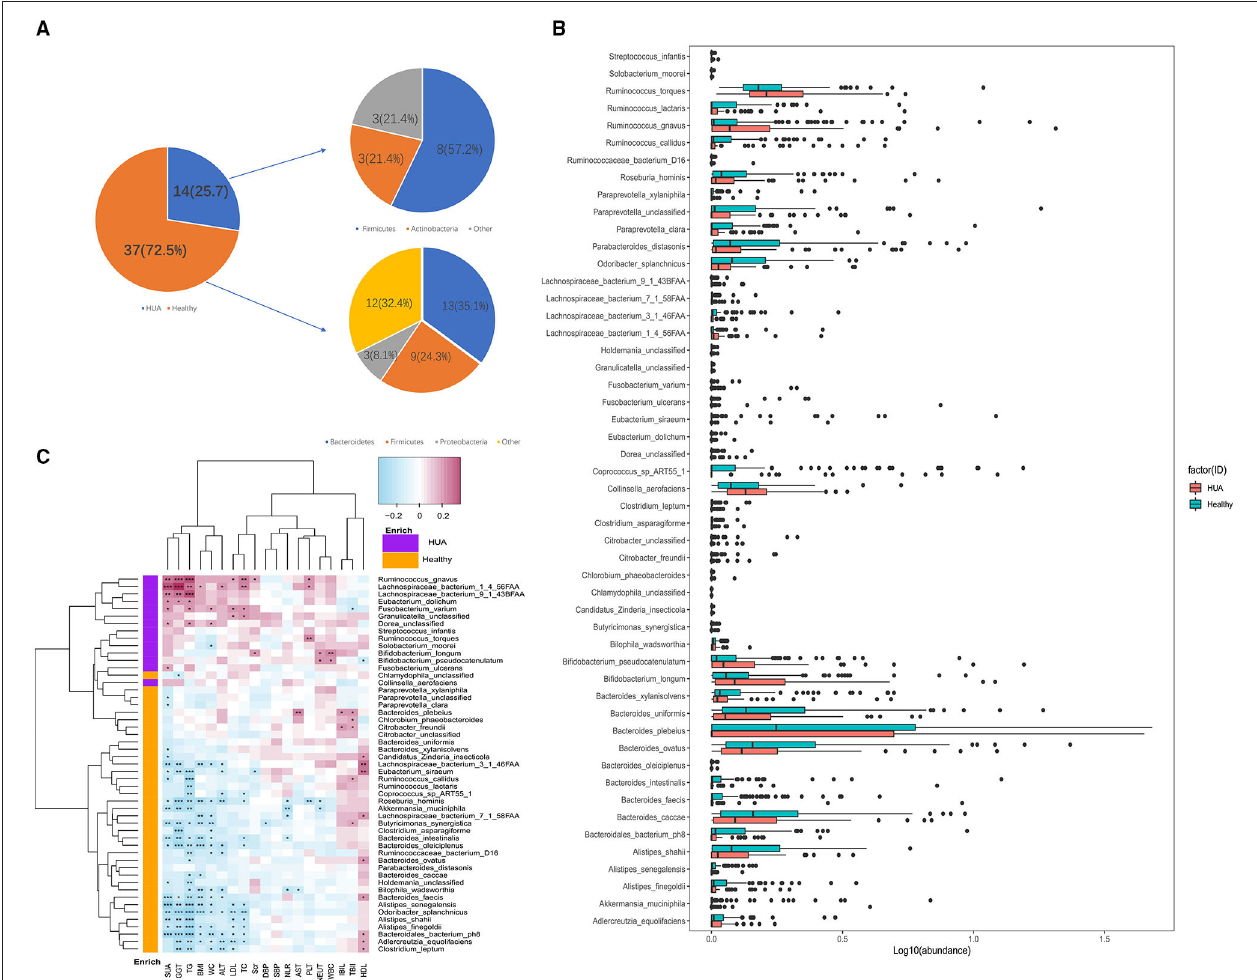
FIGURE 2 | Microbiome differences between HUA group and healthy controls and the correlations with clinical characteristics. (A,B) Abundance of bacterial species that were of significant difference between HUA group and healthy controls. (C) Correlation matrix for bacterial species and clinical characteristics. Cells in red represented positive correlations while blue indicated negative. Cells with *, **, or *** asterisk represented P < 0.05, 0.01, or 0.001